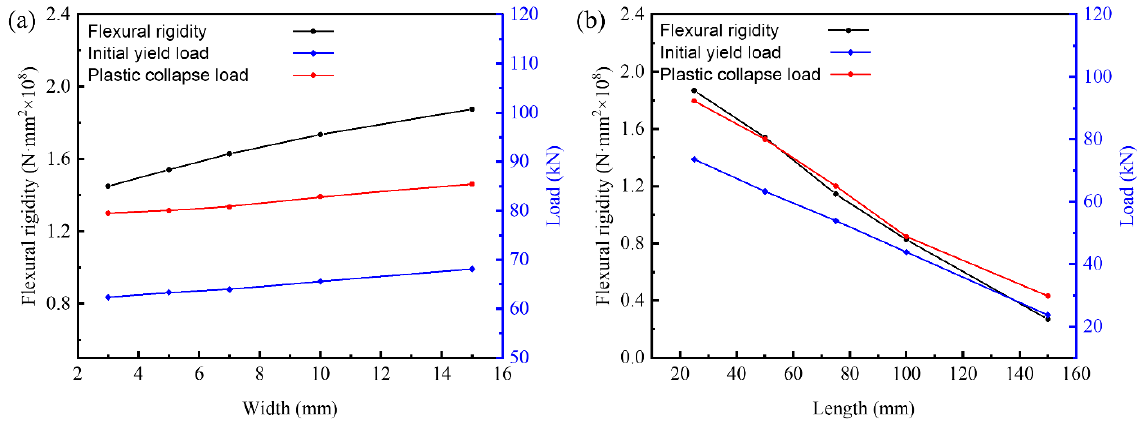
Figure 13. Effects of beam width ( a ) and length ( b ) on properties of the panel-to-panel construction. It is worth noting that the deformation of the panel-to-panel LTPS can transform to mode Ⅱ with the increase in I-beam length, as shown in shown in Figure 14. For this deformation mode, the equilibrium relation under three-point and four-point bending was written as Equation (58).